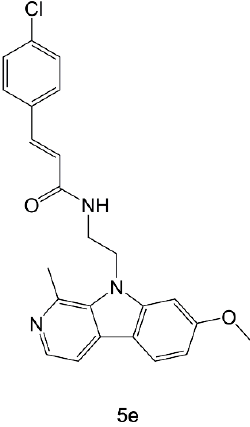
Figure 10. Chemical structure of 5e [109].